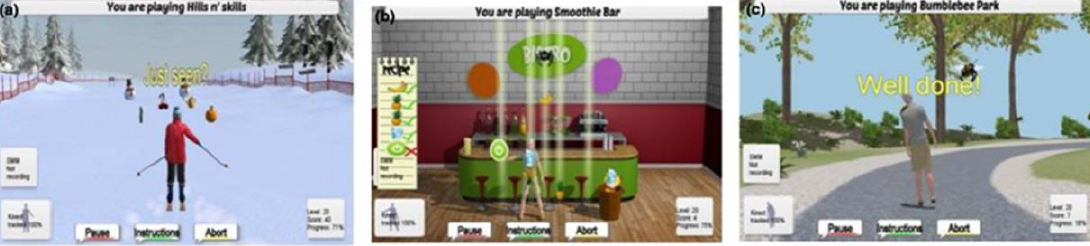
Figure 4. The three purpose-built exergames (( a ) Hills ‘n’ Skills, ( b ) The Bistro and ( c ) Bumble Bee Park) integrated into the iStoppFalls ICT-based system. (Permission granted by the Dr Rainer Wieching—PI, [57]).